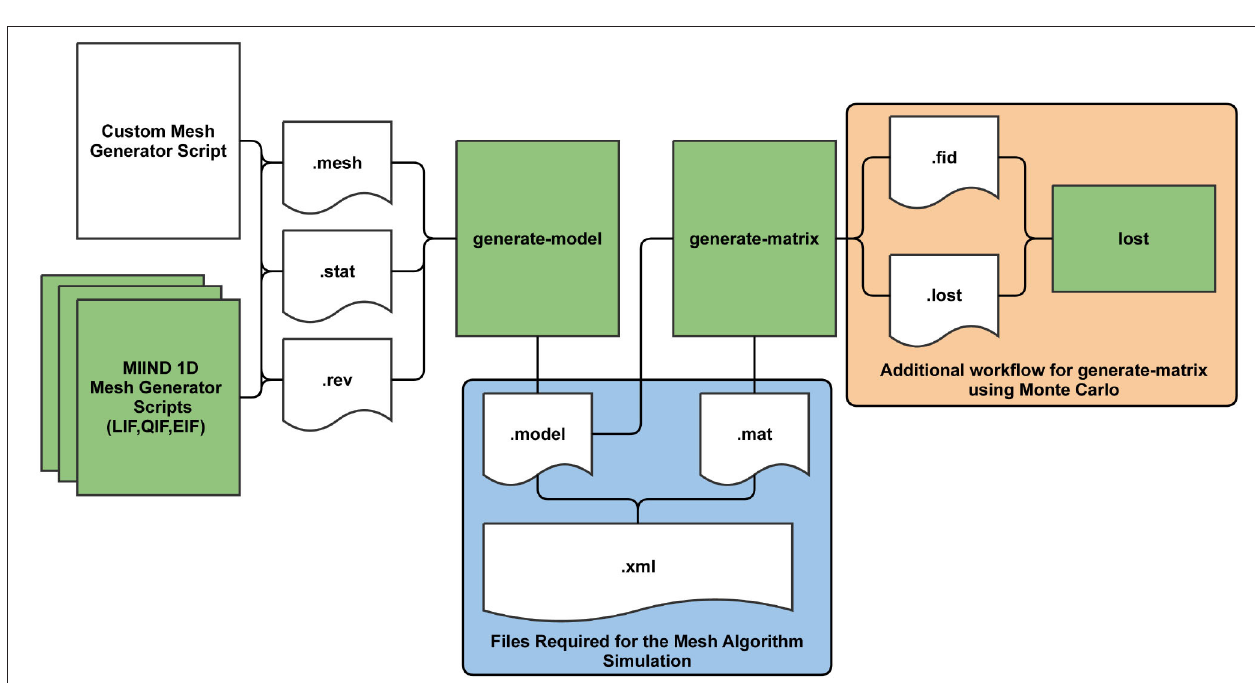
FIGURE 10 | The MIIND processes and generated files required at each stage of pre-processing for the mesh algorithm. The shaded green rectangles represent automated processes run via the MIIND CLI.